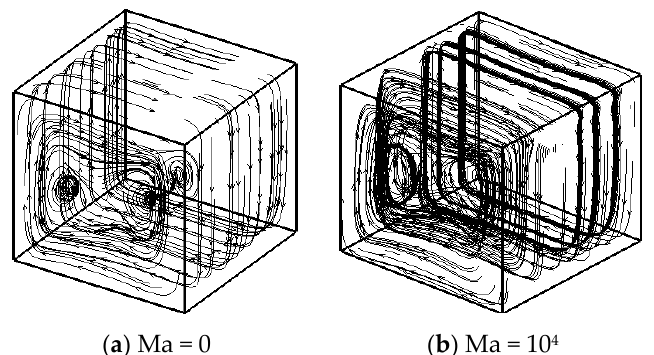
Figure 2. Some particles’ trajectories are not subjected to magnetic field (Ha = 0) for Ra = 10 5 ; (a) Ma = 0 and (b) Ma = 10 4 .